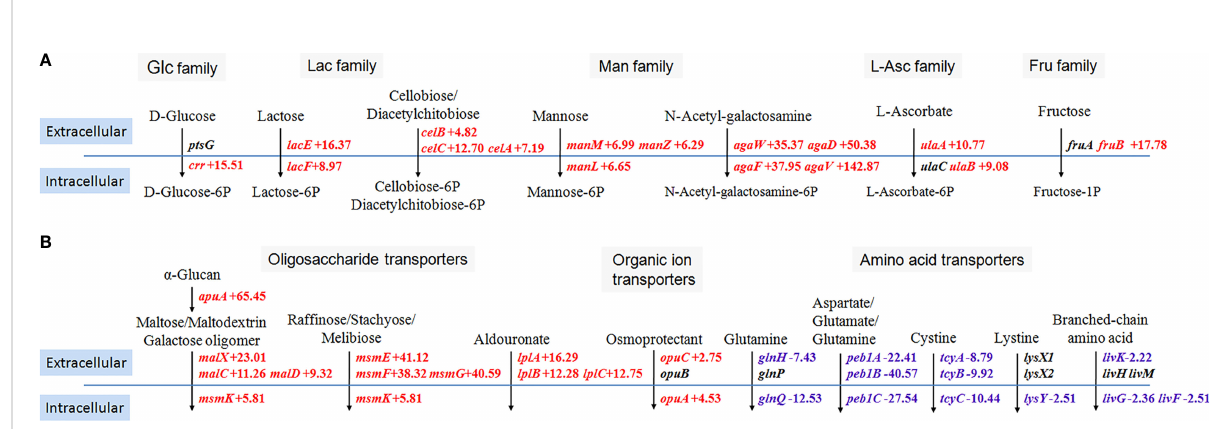
FIGURE 2 Schematic summary of differentially expressed genes involved in the phosphotransferase system (A) and ATP-binding cassette transporters (B) . Glc, glucose; Lac, lactose; Man, mannose; L-Ascorbate; Fru, fructose. Transcriptome data from bacteria grown in glucose served as the reference data. The solid blue lines indicate the cell membrane of S. suis . The black arrows indicate speci fi c transport processes. Transport of carbohydrates across the cytoplasmic membrane by PTS couples with their simultaneous phosphorylation. Red color, up-regulated genes; blue color, down-regulated